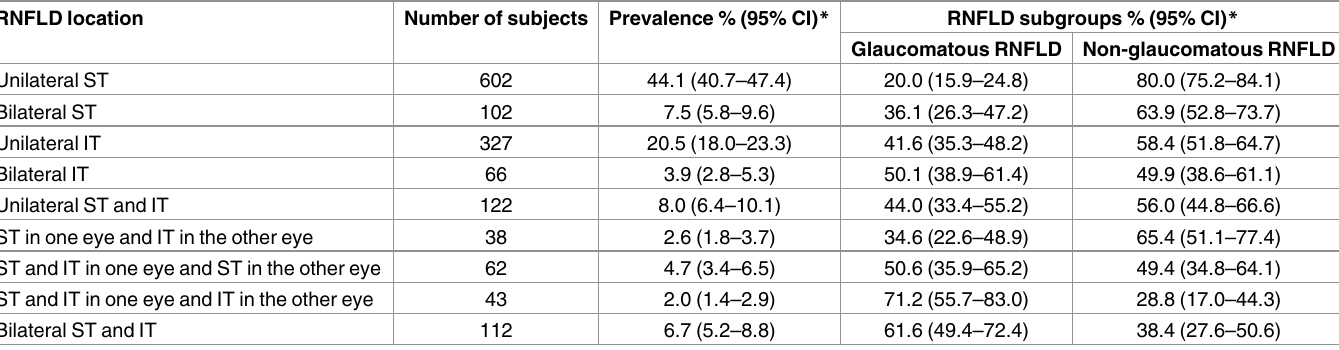
Table 2. Location of retinal nerve fiber layer defects in 1,474